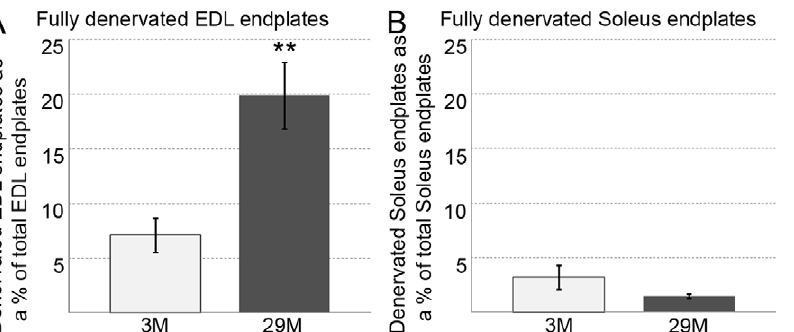
Figure 3. Percent of fully denervated NMJ in EDL (A) and soleus (B) muscles from 3 and 29 month old mice. There was a significantly increased number of fully denervated endplates in geriatric EDL (A) but not soleus (B) muscles. N=4 mice per age group. **P , 0.005. Values are mean